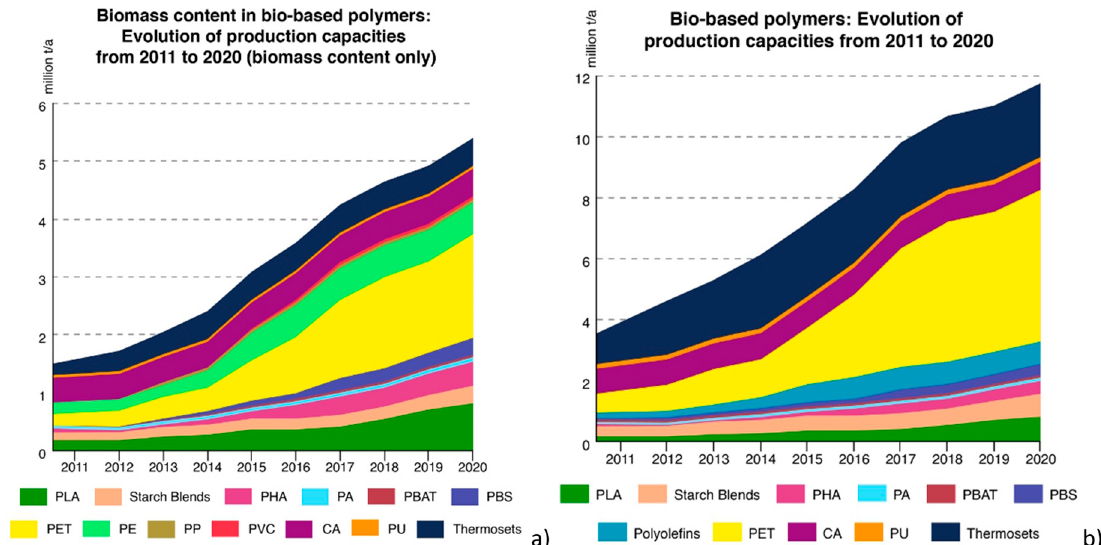
Figure 9. Bio-based polymers: Biomass content utilized in bio-based polymeric matrices ( a ); and development of production capacities from 2011 to 2020 ( b ) [282].